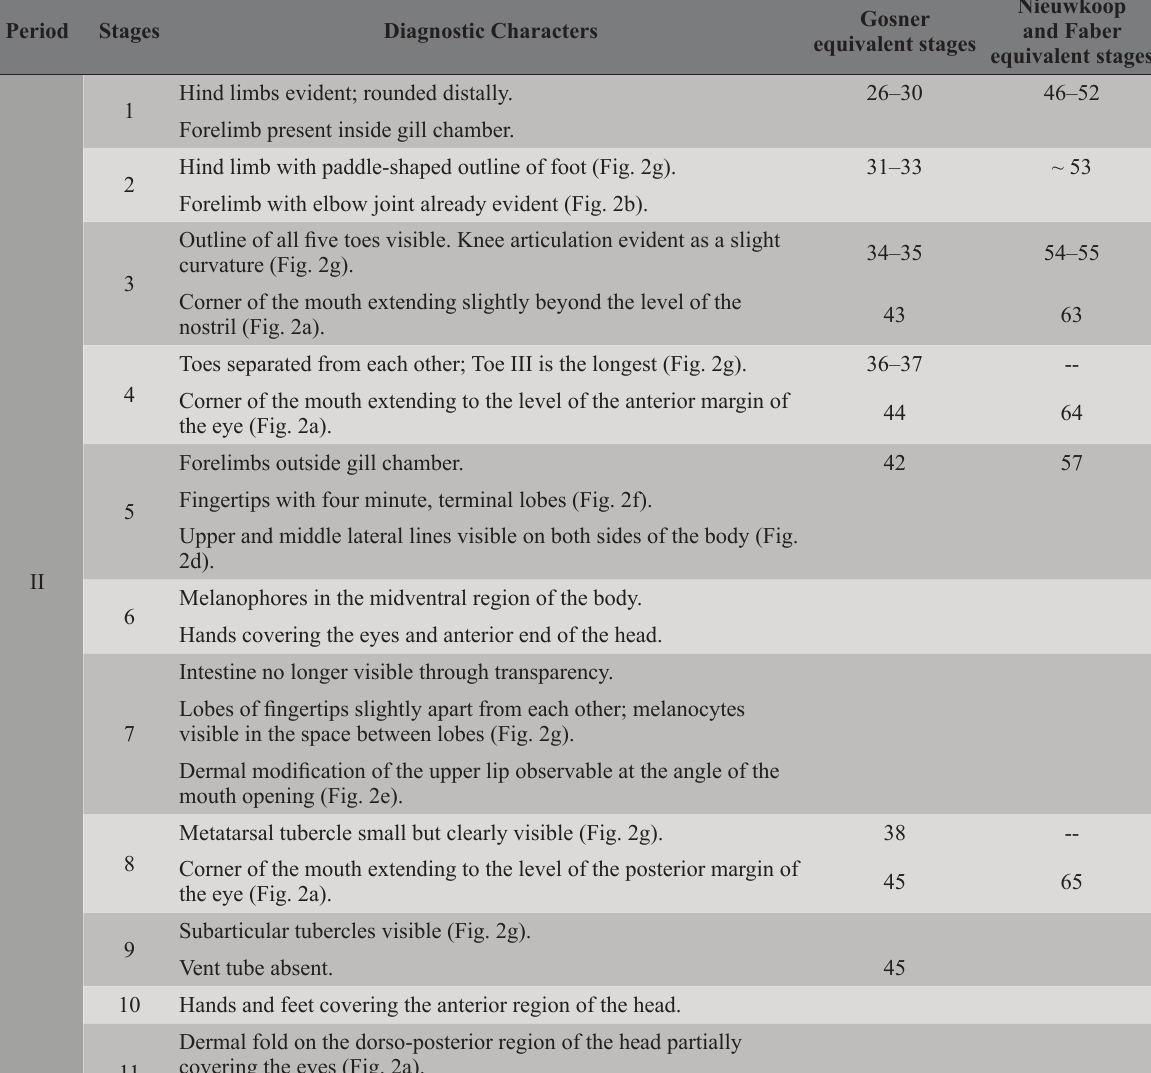
A simplified table for staging Pipa arrabali embryos based on key diagnostic characters. The correlations of diagnostic characters between this table and the staging tables proposed by Gosner (1960) and Nieuwkoop and Faber (1954) are